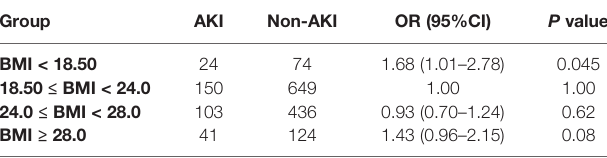
TABLE 2 | The association between BMI and